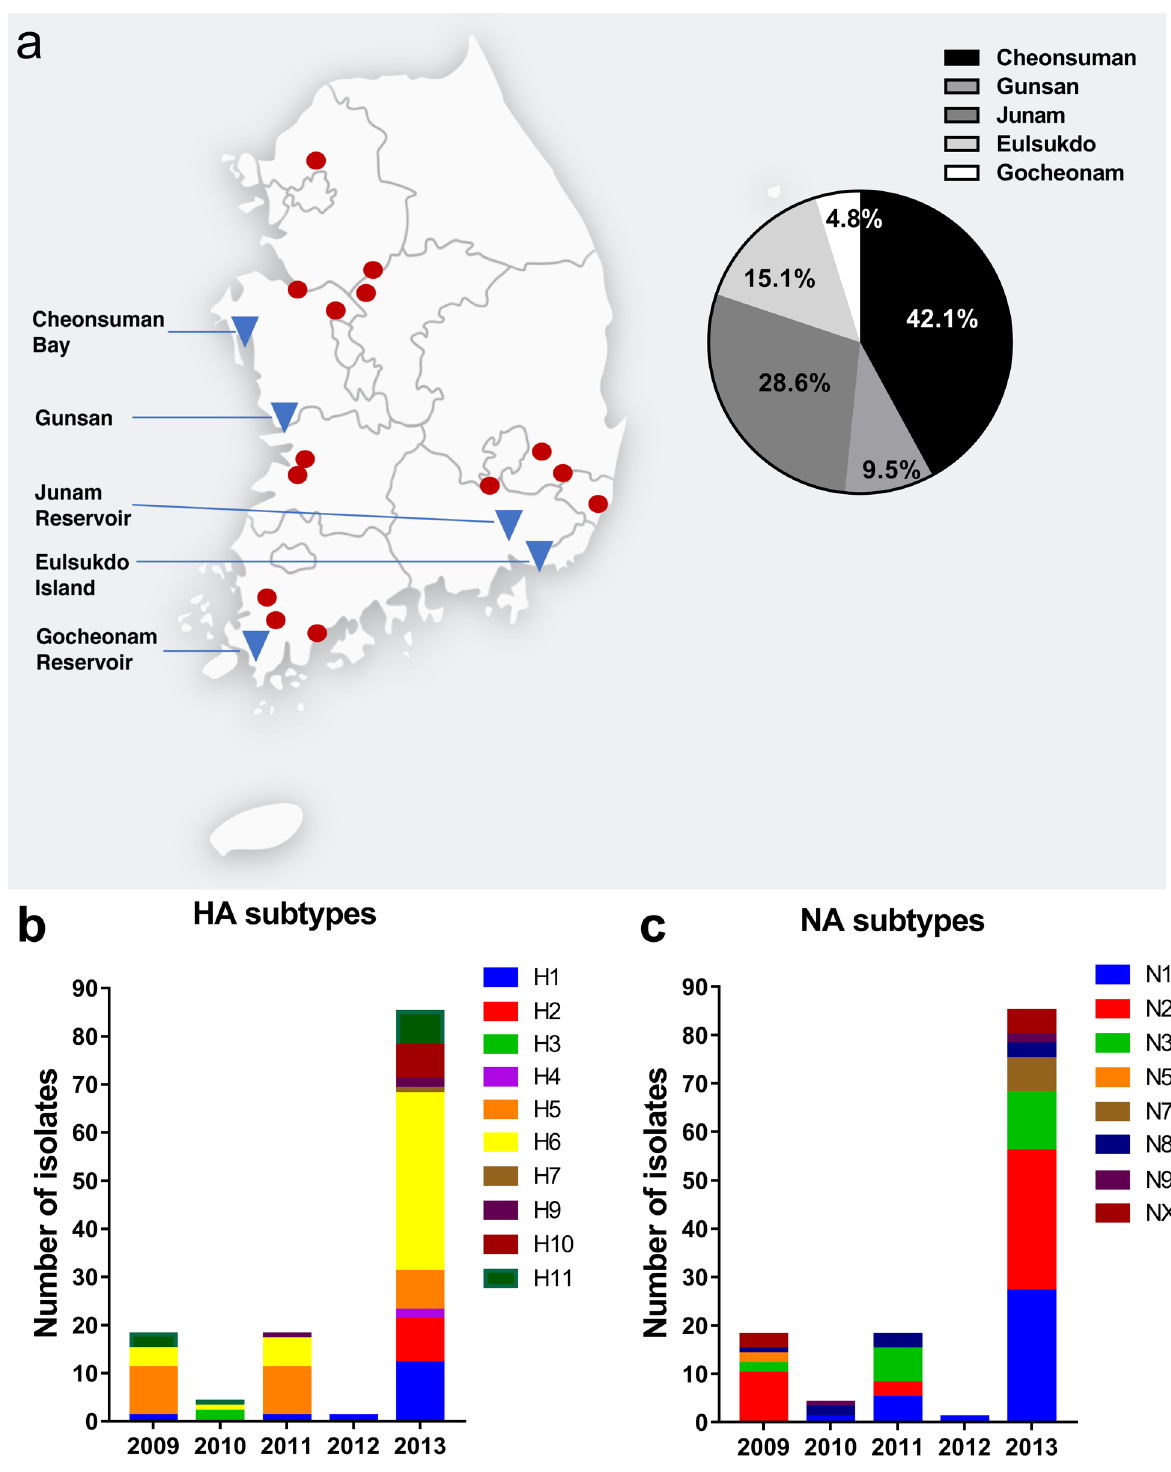
Figure 1. Sampling sites and hemagglutinin (HA) and neuraminidase (NA) subtypes of isolated avian influenza viruses from the fecal matter of wild migratory birds from 2009–2013. ( a ) Sampling sites (triangles) from 2009–2013, and representative clusters of highly pathogenic avian influenza outbreaks in poultry in South Korea from 2008–2014 (circles). Frequencies of isolates (out of 126 total isolates) per sampling site are shown in the pie chart. All ( b ) HA and ( c ) NA subtypes were identified through reverse transcription polymerase chain reaction using universal